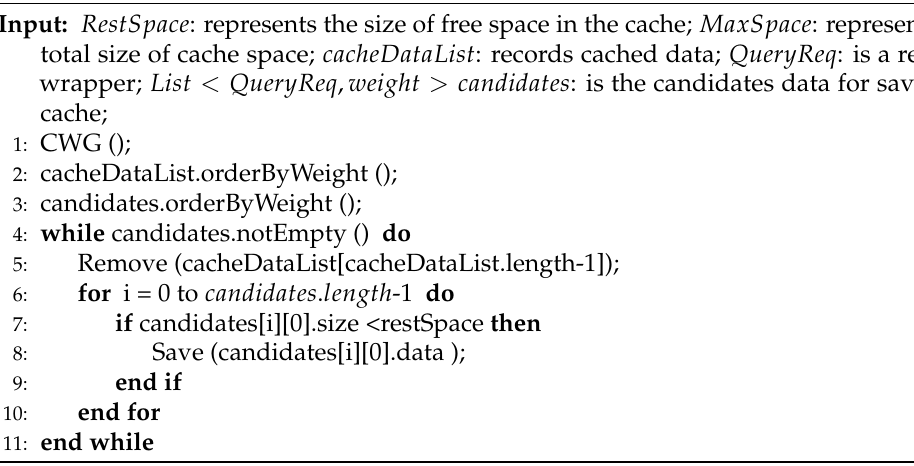
Algorithm 2 CREP